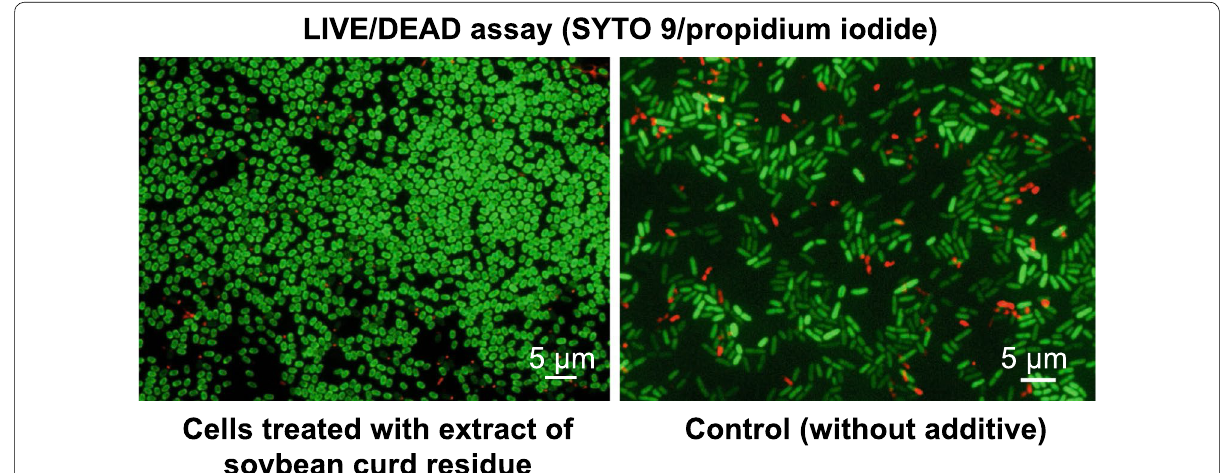
Fig. 1 Sporulation induction on vegetative cells of B. amyloliquefaciens AHU 2170 by an extract from soybean curd residue. An active fraction obtained by preliminary cation-exchange chromatography induced pellicle along with sporulation induction at a concentration equivalent to 1 g fresh weight of soybean curd residues per mL MSG medium after 48-h incubation ( left ), while control without any additives did not ( right ). Bacterial cells were stained with SYTO 9/propidium iodide for bacterial LIVE/DEAD assay. Note that shapes of the spore cells stained by SYRO 9 are clearly distinguishable from rod-shaped vegetative